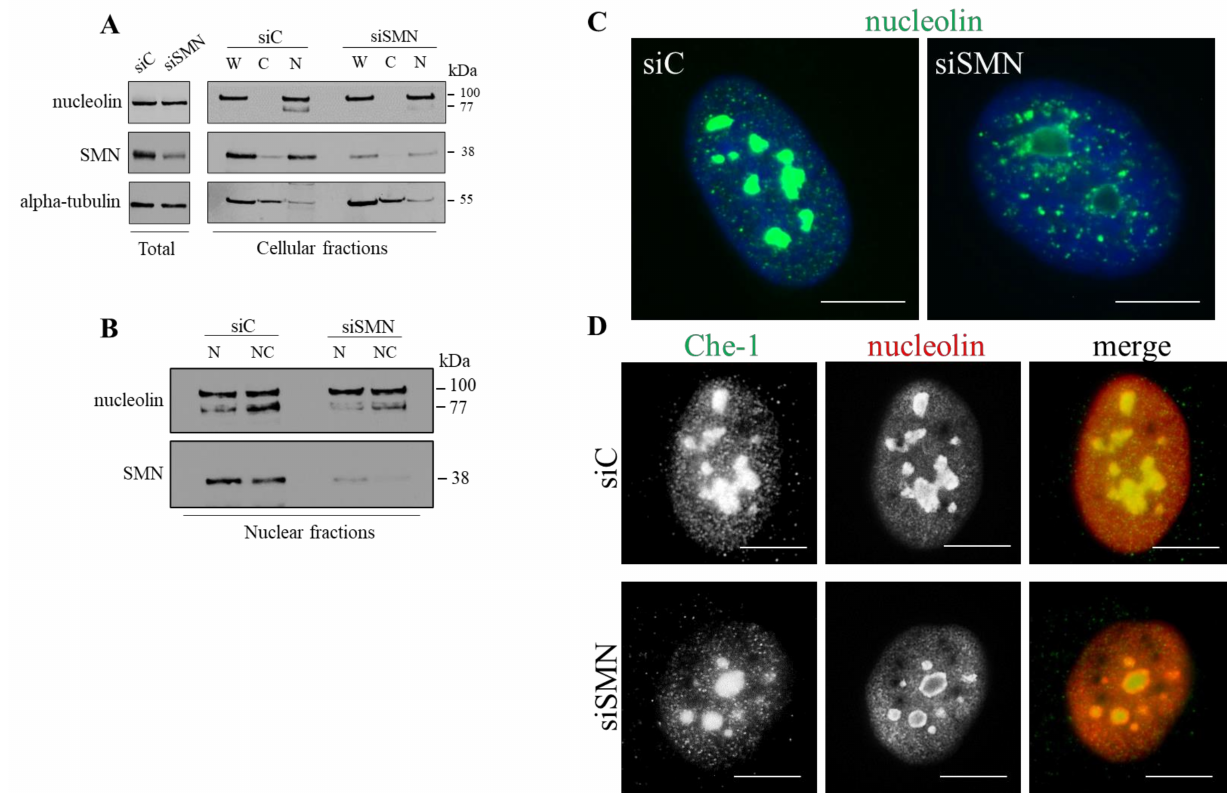
Figure 2. SMN deficiency impairs nucleolar localization of nucleolin. ( A , B ) hTert-Fibroblasts, transiently transfected with SMN1 siRNA (siSMN) or scrambled siRNAs, as control (siC), were subjected to subcellular fractionation. ( A ) Immunoblot- ting shows the abundance of the indicated proteins in each subcellular fraction (W = whole-cell extract; C = cytoplasm; N = nucleus); ( B ) nuclei (N) and nucleoli (NC) isolated from the transfected fibroblasts were checked by immunoblotting. Representative panels of n = 3 independent experiments. ( C , D ). Representative immunofluorescence of siSMN- or siC- transfected hTert-Fibroblasts; ( C ) Cells were immunostained for nucleolin (green). Scale bar 5 µ m. ( D ) The transfected fibroblasts were subjected to dual immunostaining for the nucleolar marker Che-1, and nucleolin (green and red, respectively, in the merge). Scale bar 5 µ m. In C and D , nuclei were stained with DAPI